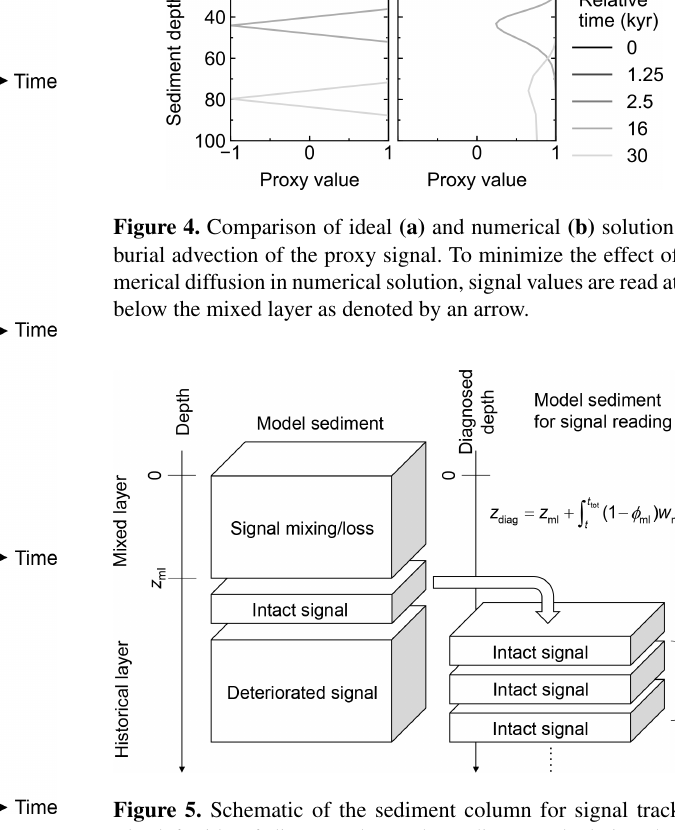
Figure 3. Schematic of signal tracking simulation. Input proxy sig- nal X (solid line in the uppermost panel) is reflected in rain fluxes of multiple classes of CaCO 3 particles using three different meth- ods (a–c) . Method 1 (a) approximates the input proxy signal by a step function (dotted line in the uppermost panel) and uses dif- ferent classes of CaCO 3 with separate and unique proxy values at individual time steps. The rain flux of each CaCO 3 class can take either 0 or the total rain flux value J T . Method 2 (b) uses CaCO 3 classes with the maximum and minimum values of proxy (A and B), and rain fluxes of these CaCO 3 classes are changed so that flux- weighted sums of proxy values of CaCO 3 classes become the same as the input proxy values. Method 3 (c) separates bulk CaCO 3 into CaCO 3 classes that define the proxy signal (classes Y and G), and rain fluxes of these CaCO 3 classes are calculated based on the proxy signal values (see boxes). See Sect. 2.4.1 for more details.